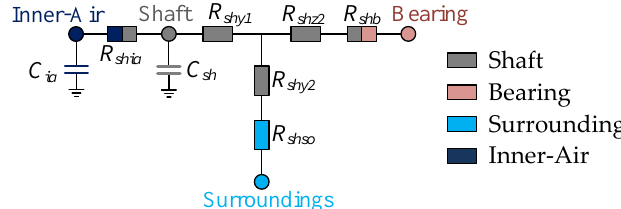
Figure 9. Thermal model of the shaft.